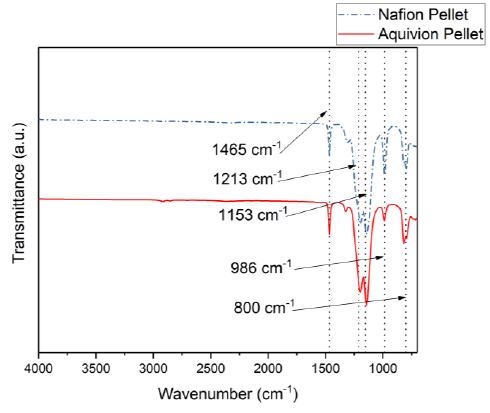
Figure 6. FT-IR results comparing Nafion and Aquivion precursor pellets.